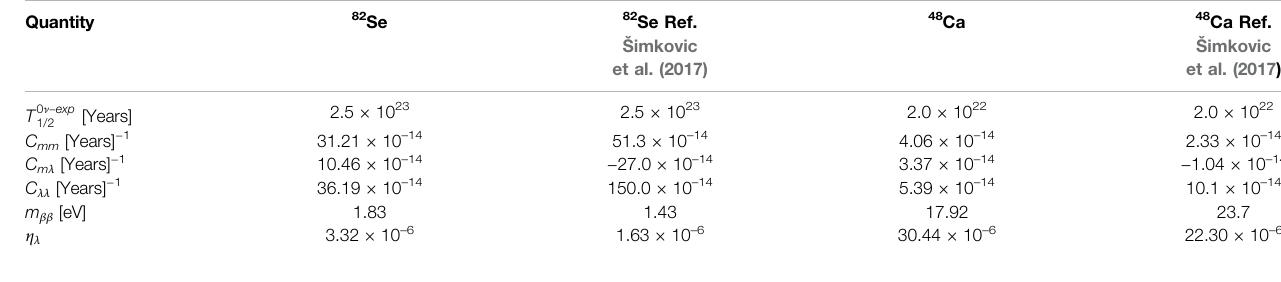
TABLE 3 | Results for half-life and bounds on neutrino mass and lepton number violating parameters. The T 0 ] − exp 1/2 is taken from the experimental lower limit on half-life from Ref. (Arnold et al., 2005) for 82 Se and from Ref. (Arnold et al., 2016) for 48 Ca. All results are for AV18 type SRC parameterizaionparameterization. We have assumed CP conservation ( ψ (cid:1) 0). The results are compared with QRPA calculations for λ mechanism of Ref. ( Š imkovic et al.,